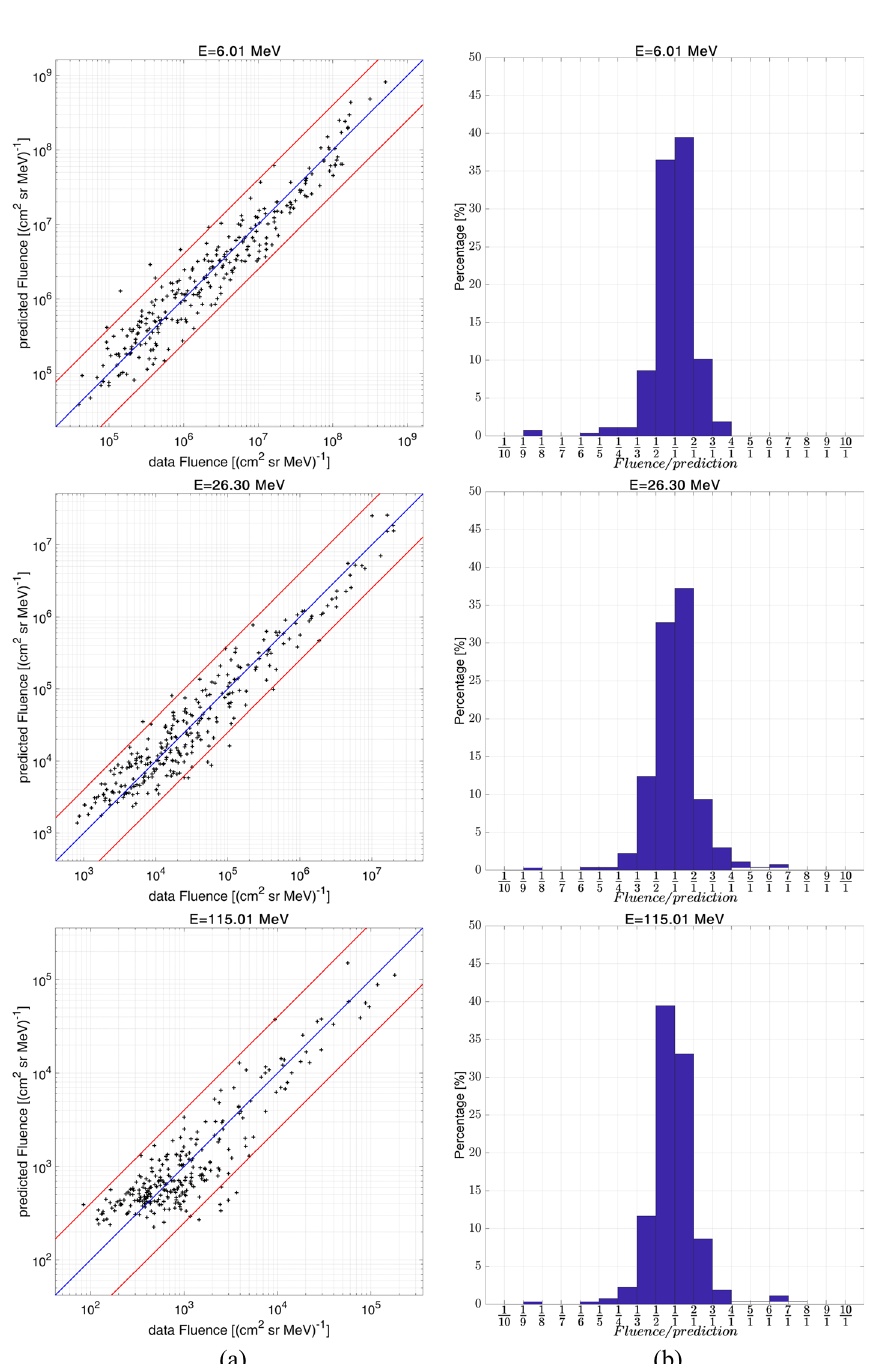
Fig. 12. (a) Cross-plots of measured and predicted Event Fluences at 6 MeV, 26.3 MeV and 115 MeV, y = x equality lines are in blue and y = 4 x and y = 0.25 x lines are in red above and below respectively. (b) Distributions of the fraction of Fluence over predictions at the same